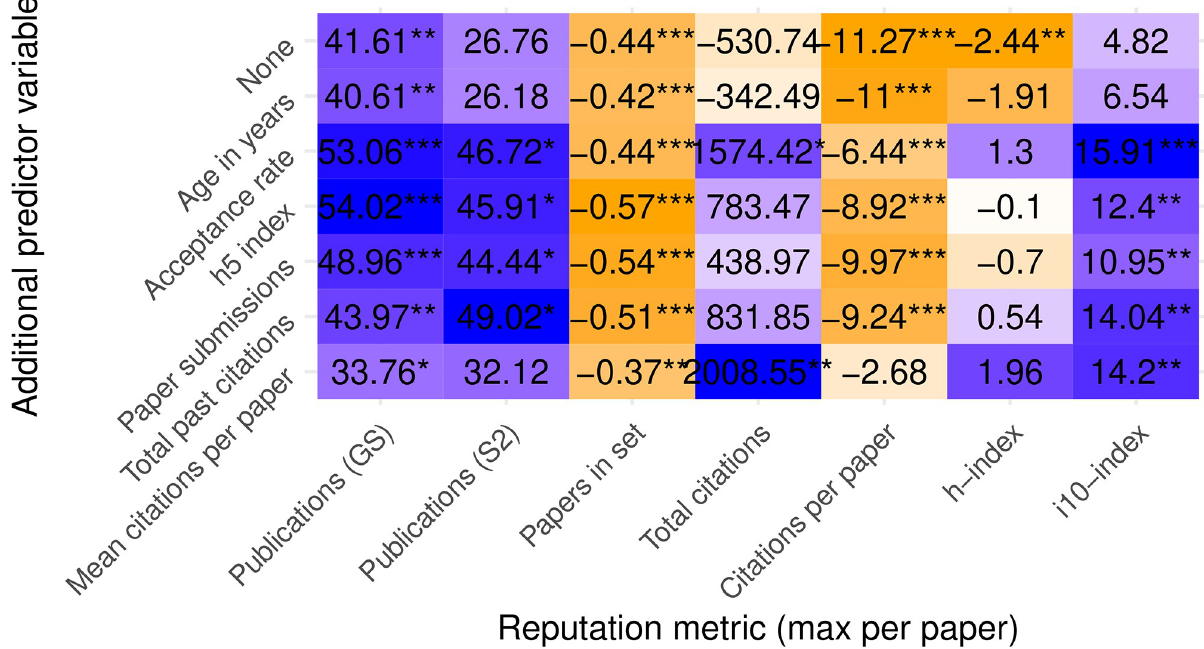
Fig 8. Linear regression of various author prestige metrics as predicted by review policy and other conference variables. Values shown are the coefficient of the reviewing policy variable in the linear model and their associated p-values. Positive coefficients (purple) indicate higher reputation in SB conferences. Negative coefficients (orange) indicate higher reputation in DB conferences. Darker colors reflect larger-magnitude values, normalized by columns. Stars indicate p values below 0.05, 0.01, and 0.001, respectively.